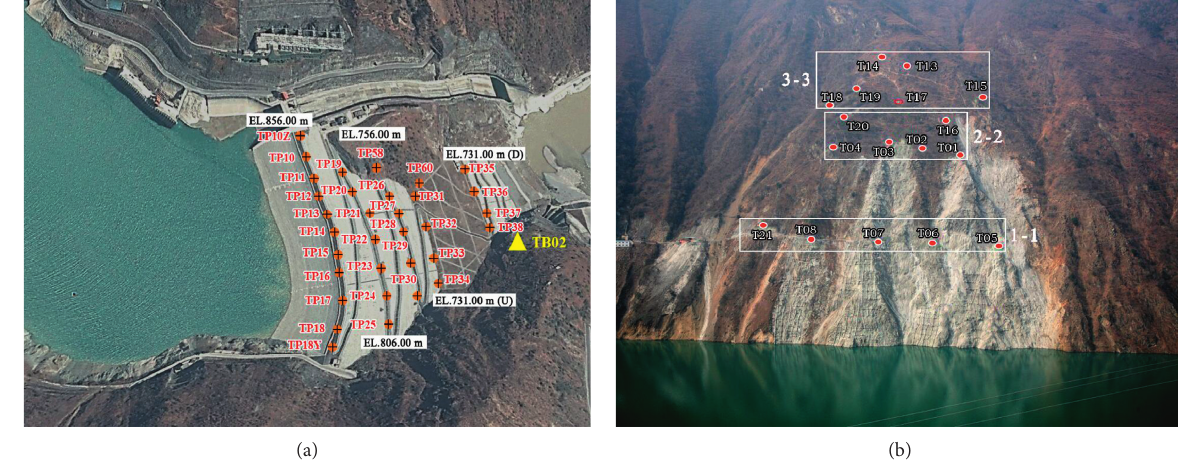
Figure 7: Measuring points of (a) the dam and (b) the slope.